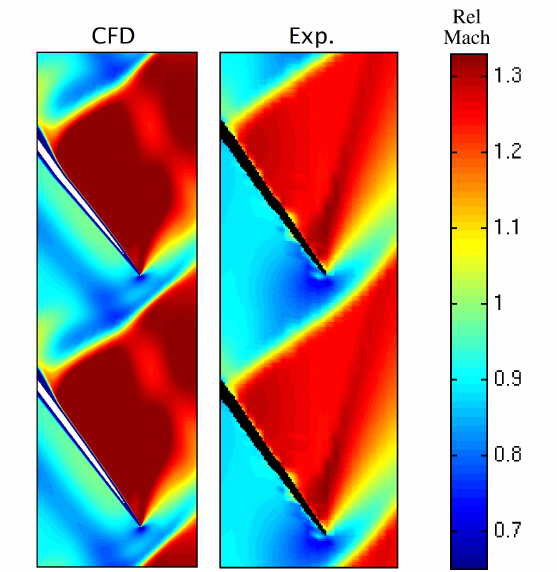
Figure 7. Comparison of CFD and experimental relative Mach number distribution on a constant radius section 263.1 mm from the axis for single-point take-off